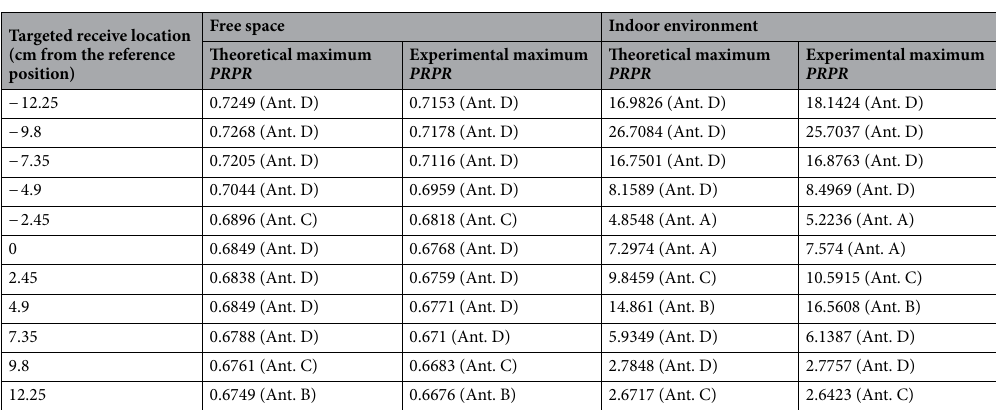
Table 1. Comparison of theoretical and experimental maximum PRPR values for each targeted received